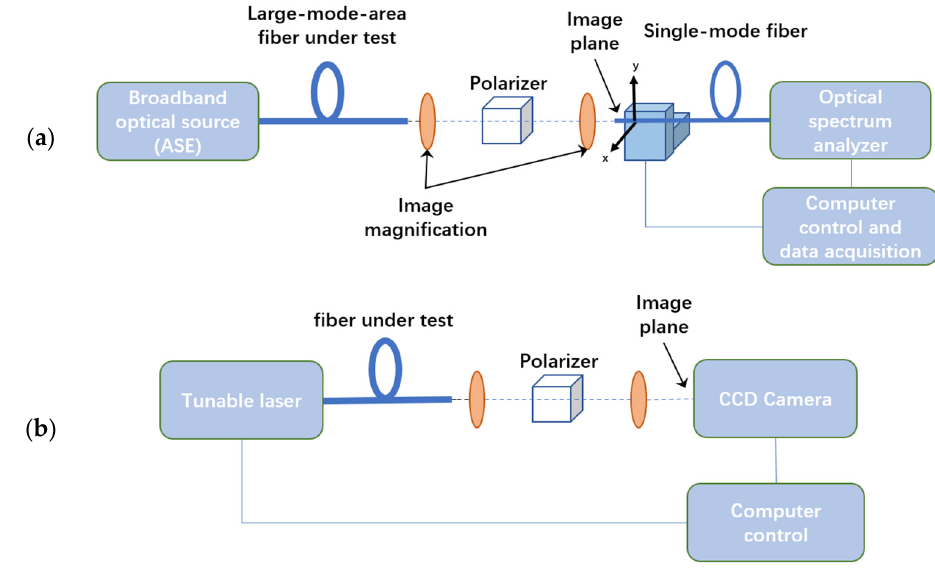
Figure 2. ( a ) S 2 testing system (ASE + OSA); ( b ) Updated S 2 testing system (TLS +